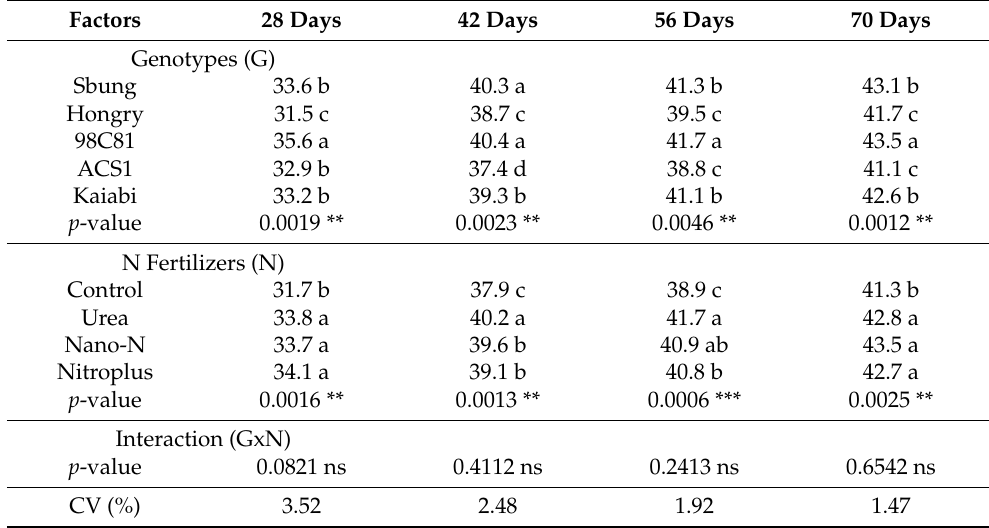
Table 2. Leaf chlorophyll index at different days as affected by genotypes and N fertilizer sources.